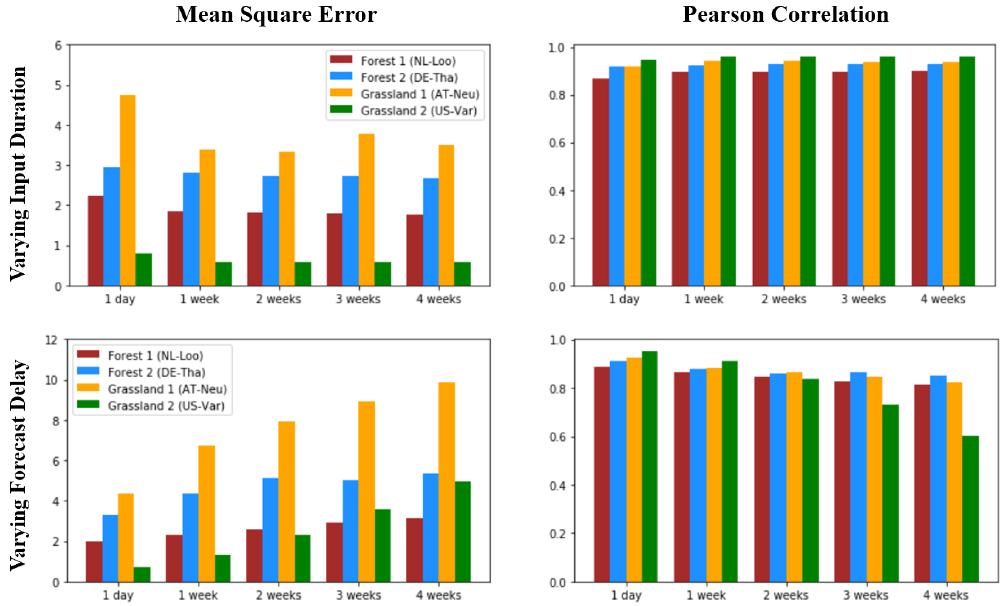
Figure 2. The past-history dependency and GPP forecasting ability of the LSTM model. Upper panel: predicting the current GPP using varying length of historic data on climate drivers. Lower panel: predicting the GPP on varying days ahead in the future using the same two-week length of historic